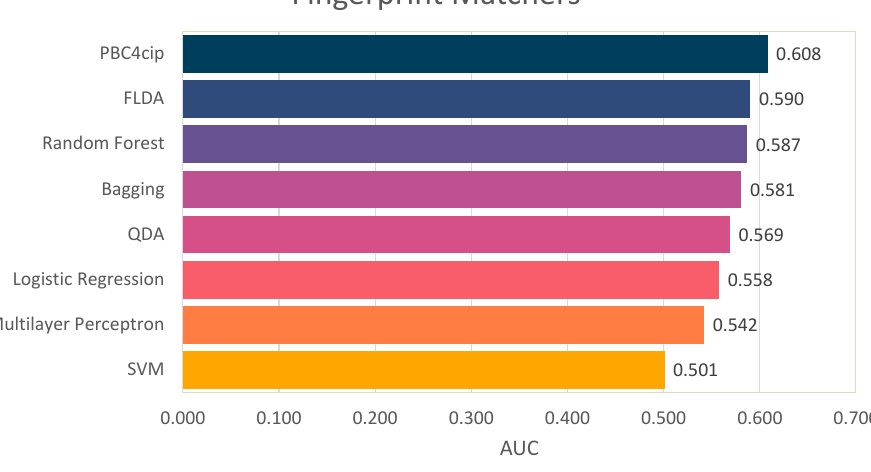
Figure 11. Average AUC for eight different classifiers tested on our minutiae